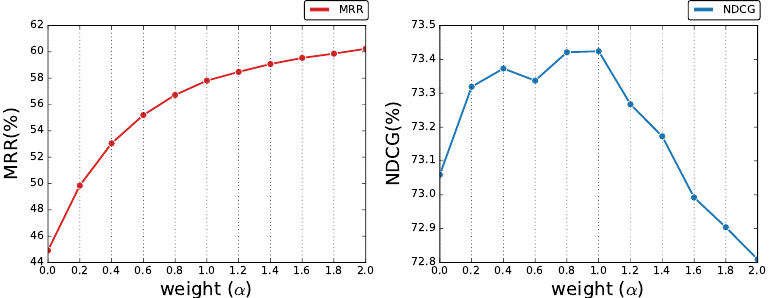
Figure 3. Performance of Multi-View Attention Network (MVAN) according to the ratio of relevance loss and discrimitive loss on the VisDial v1.0 validation